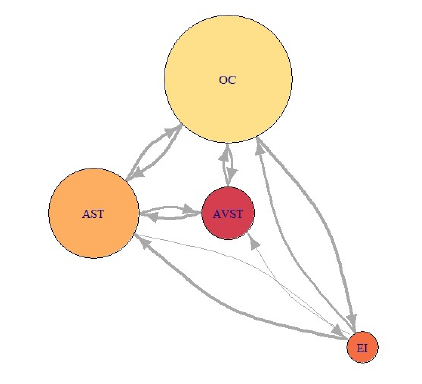
Figure 22. Network visualization of EM data for partic- ipant P9 during Climbing.